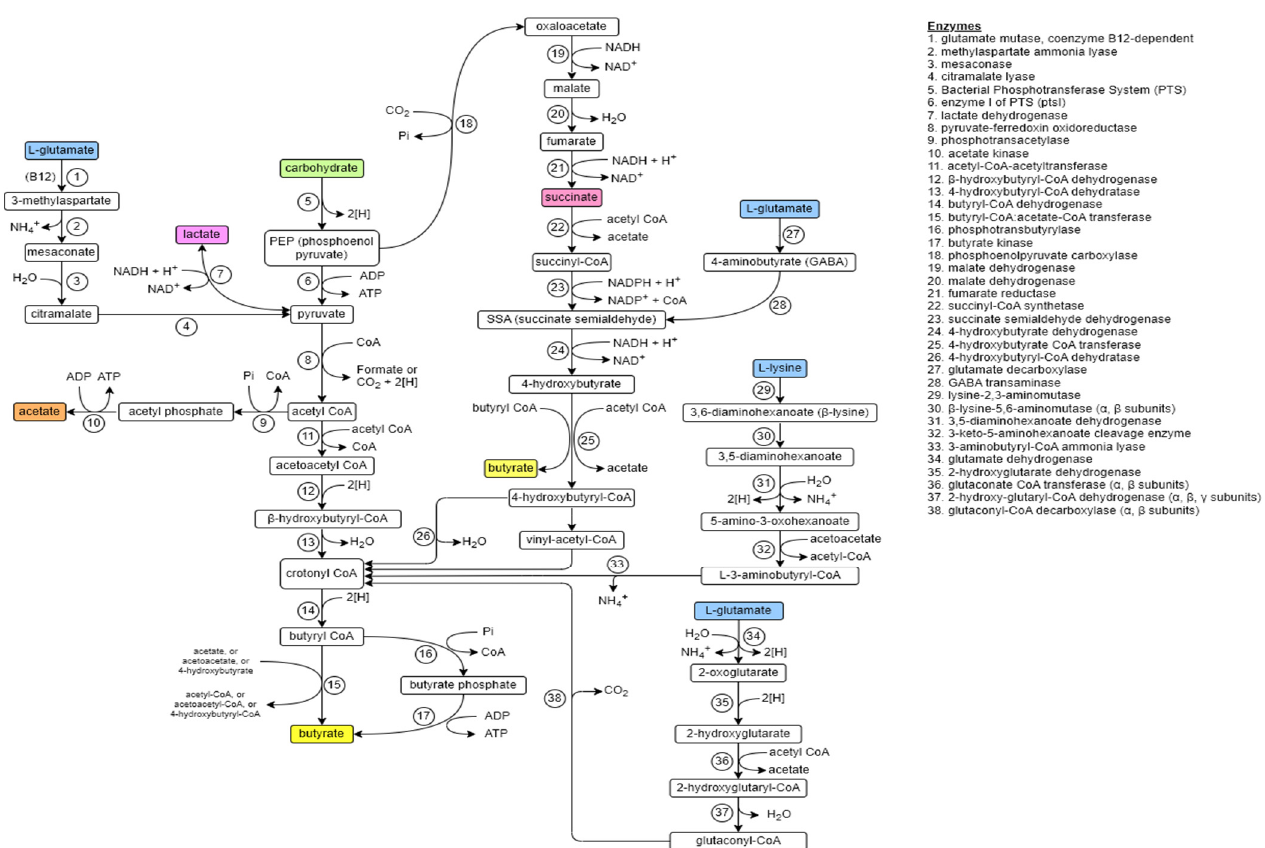
Figure 1. Butyrate biosynthesis and related enzymes and byproducts in the process. Diagram shows the biosynthesis of butyrate (in yellow) through several sources such as organic acids (lactate, acetate, succinate; in purple, orange, and pink, respectively), amino acids (L-glutamate, L-lysine; in blue) and carbohydrate fermentation by bacteria (in green) [2,28–30,32–40].